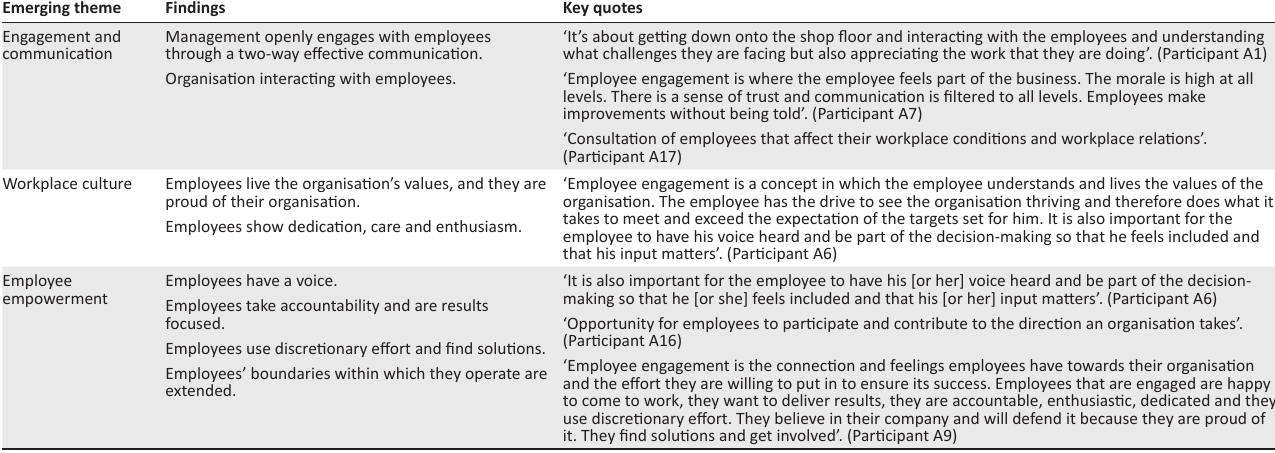
TABLE 5: Summary of findings for question 1 – Employee engagement. What do you regard as ‘employee engagement’? Emerging